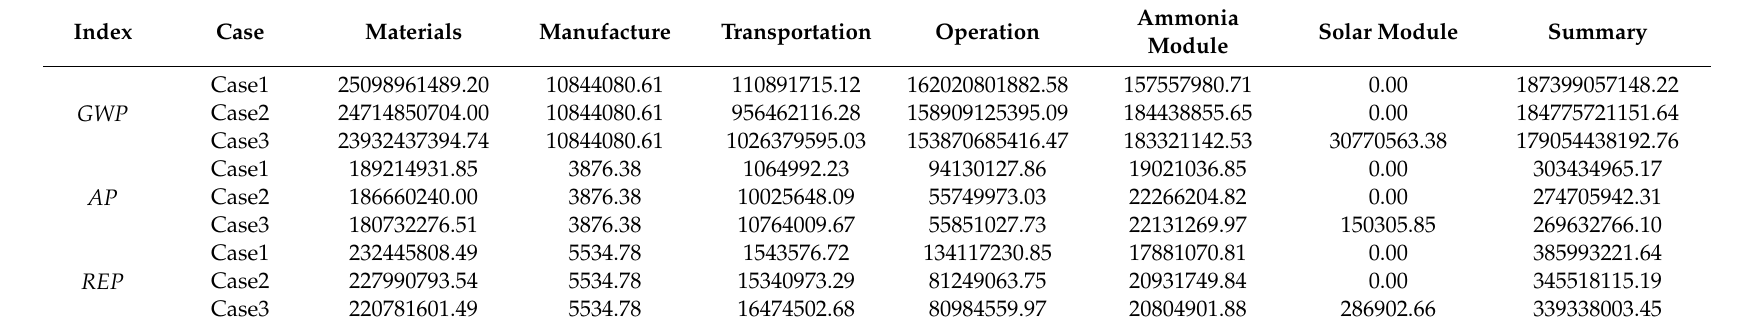
Table A2. LCA results of Cases